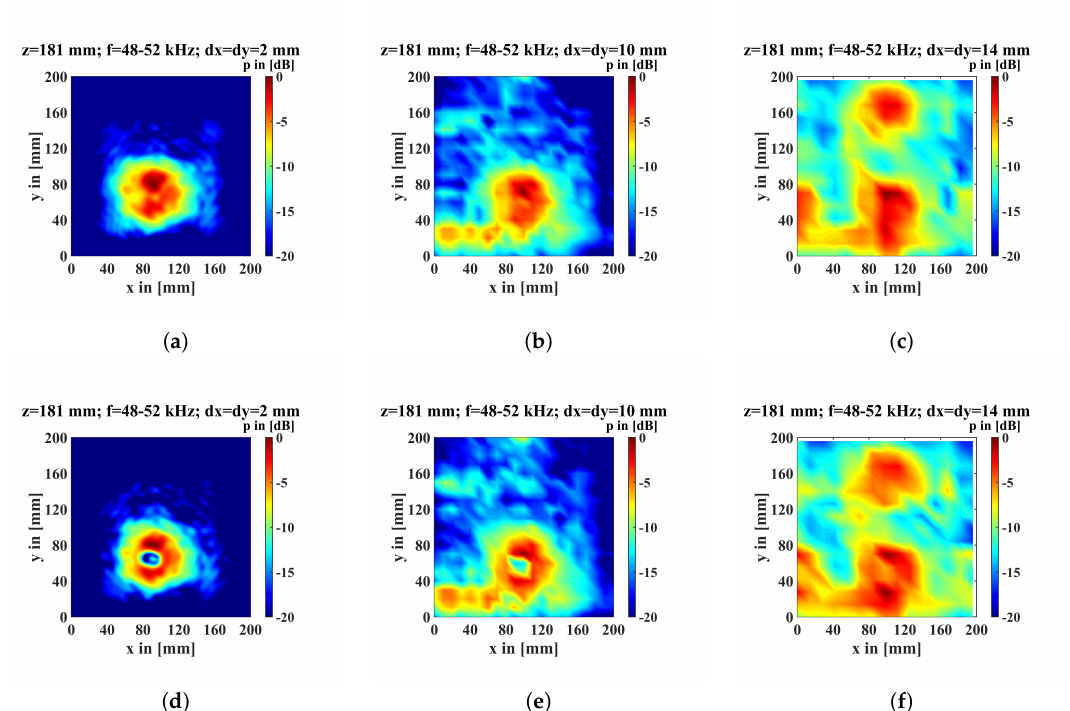
Figure 7. Back propagated amplitude with different measuring grid point distances. (Top row) With no flaw on the particleboard; (lower row) with a 20 mm flaw. ( a , d ) with a 2 mm measuring grid, ( b , e ) with a 10 mm measuring grid, and ( c , f ) with a 14 mm measuring